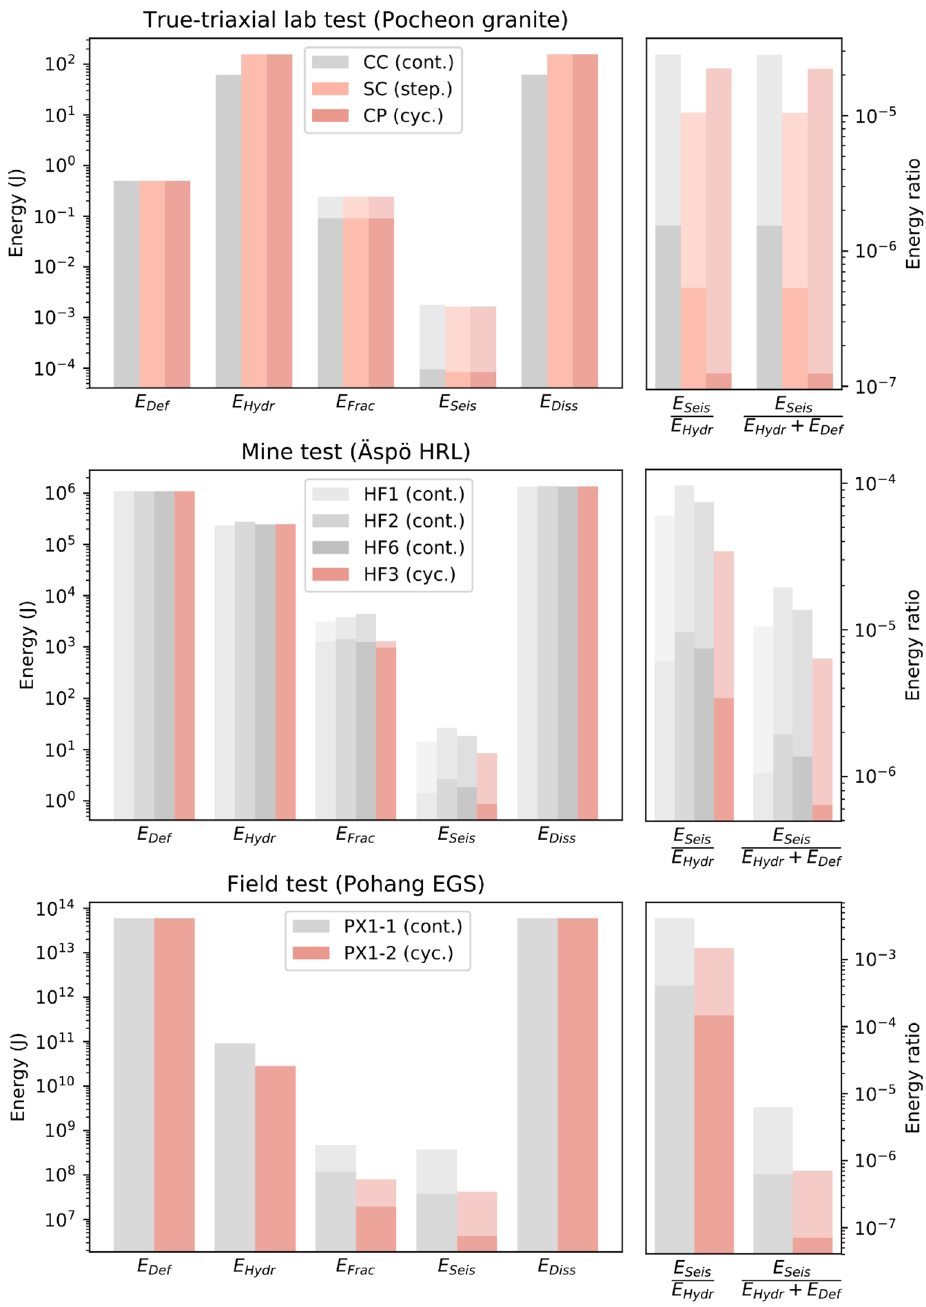
Figure 8. Energy partition in hydraulic-stimulation process. ( a ) True triaxial laboratory tests in Pocheon granite (CC = constant rate continuous, SC = stepwise rate continuous, CP = cyclic progressive); ( b ) underground test in naturally fractured granodiorite at Äspö HRL, Sweden (HF = hydraulic fracturing experiment); and ( c ) field stimulation at Pohang EGS site (PX1 = borehole PX1). All tests performed at all scales are flow-rate